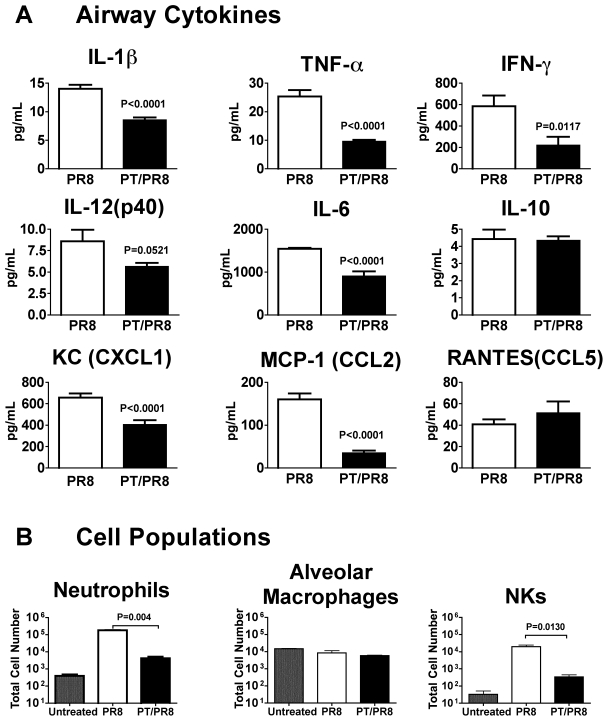
PT suppresses early pro-inflammatory responses in the airways.Groups of BALB/c mice were intranasally inoculated with 100 ng of PT or an equal volume of PBS as a control and infected with influenza PR8 (600 PFU) 24 h later. Cytokine concentrations and cellular recruitment was assessed two days after virus inoculation. (A) Lung (BAL) inflammatory cytokine levels assayed by multiplex bead array. (B) Numbers of lung immune cell populations in BAL fluid of PT-treated (PT/PR8) or PBS control-treated (PR8) mice infected with influenza virus (and in untreated mice). Neutrophils (CD11b+, Gr1hi), alveolar macrophages (CD11b−, CD11c+, F4/80+), and NK cells (NK1.1+). n = 4 mice/treatment group. Significant differences are indicated by P value.